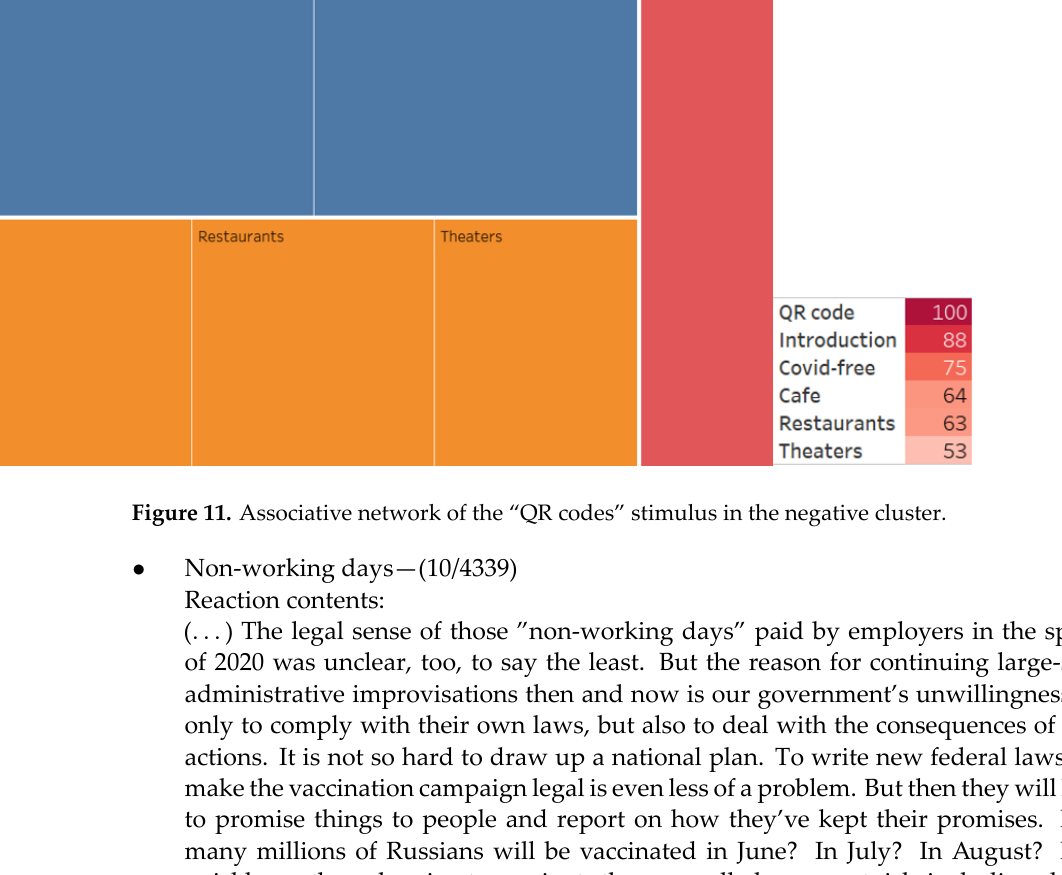
Figure 12. Associative network of the “Vaccination prize drawing” stimulus in the negative cluster. Reaction contents: The authorities intend to hold a prize drawing of five cars worth about one mil- lion rubles each week. The results will be announced on Wednesdays, starting